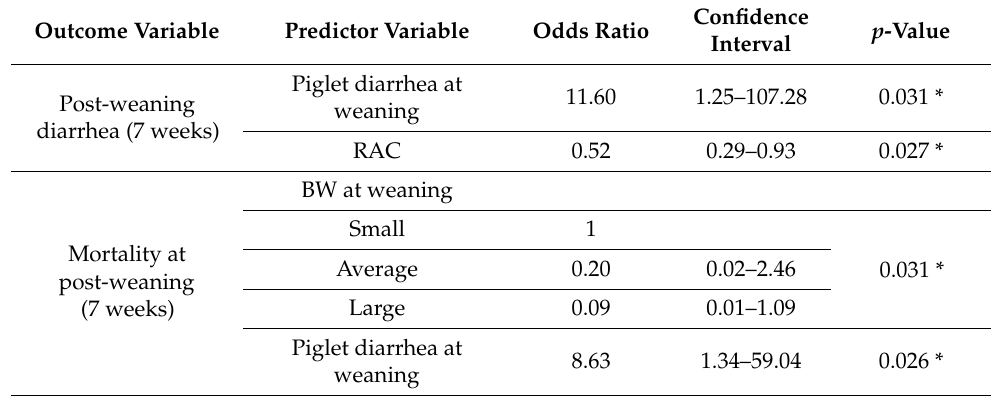
Table 3. Parameter estimates of the logit model of piglet diarrhea and mortality at 7 weeks.